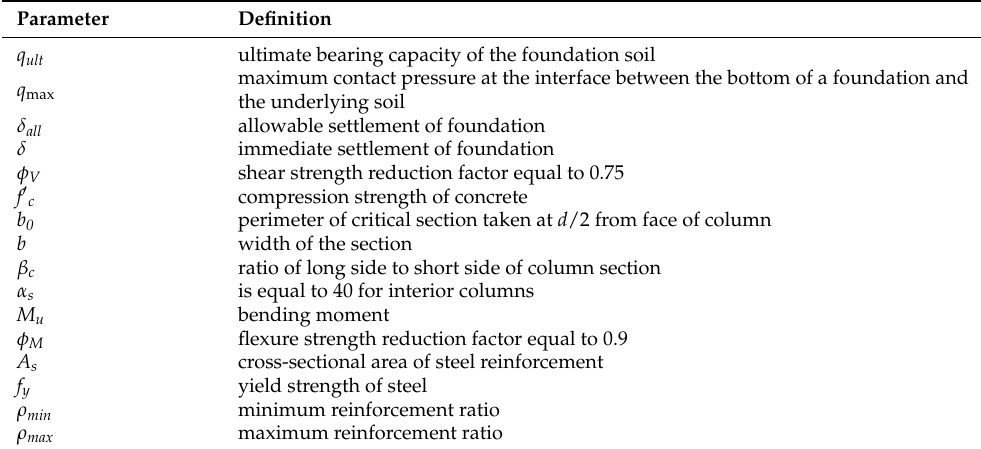
Table 9. Definition of parameters of Table 7.